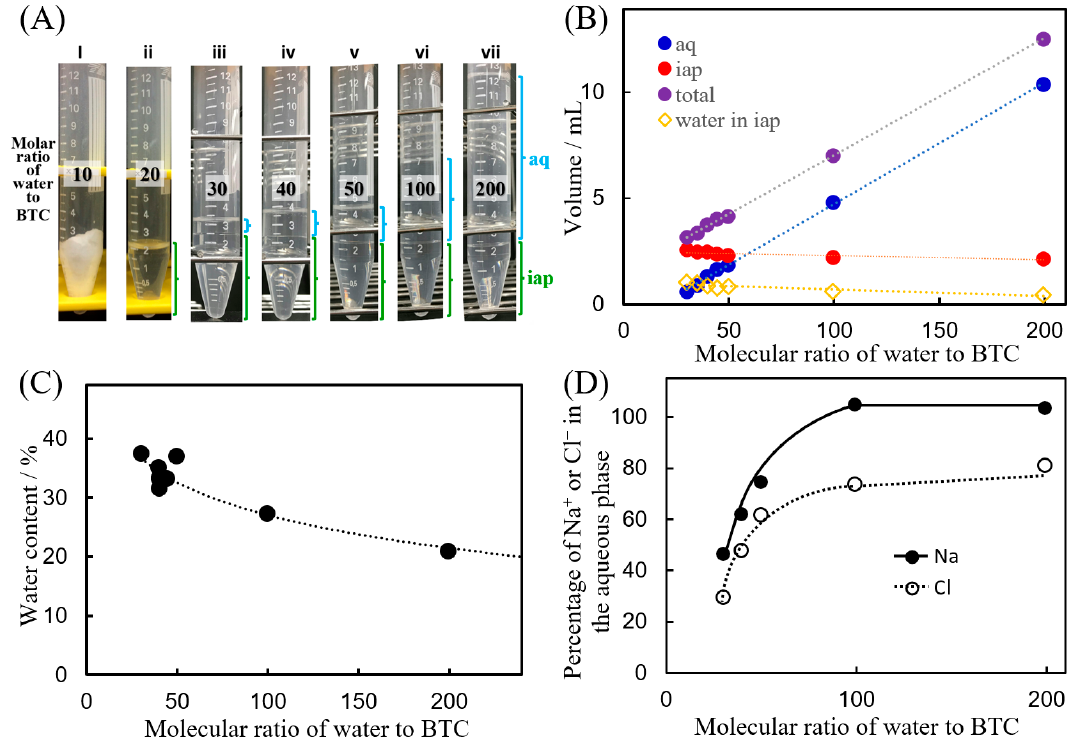
Figure 7. Effect of the molar ratio of water added to the equimolar mixture of benzethonium chloride (BTC) and sodium ethylbenzenesulfonate (NaEBS). ( A ) Photographs of solutions with different proportions of water added (i): 30 mmol (0.54 mL), (ii): 60 mmol (1.1 mL), (iii): 90 mmol (1.6 mL), (iv): 120 mmol (2.2 mL), (v): 150 mmol (2.7 mL), (vi): 300 mmol (5.4 mL), (vii): 600 mmol (11 mL)) to a mixture of BTC and NaEBS, ( B ) variation in the volume of the aqueous phase and IAPs with respect to the molar ratio of water added to the mixture of BTC and NaEBS, ( C ) change in the water content as a function of the molar ratio of water to BTC, ( D ) effect of the molar ratio of water to BTC on the proportion of sodium and chloride ions in the aqueous phase. Blue and red circles denote sodium and chloride ions, respectively.